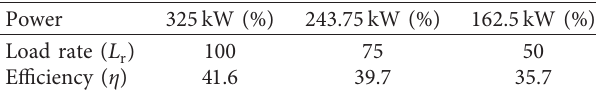
Table 5: Internal combustion generation parameter.